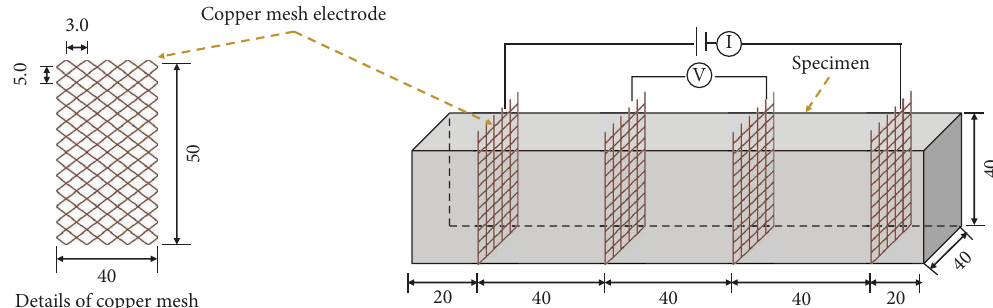
Figure 4: Confguration of copper mesh electrodes (dimensions are in mm).